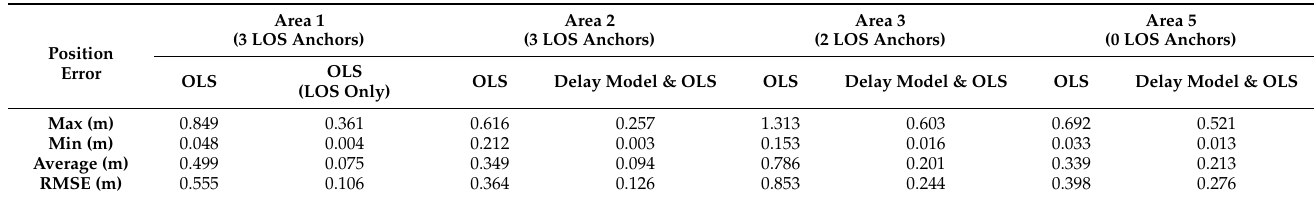
Table 4. Position accuracy analysis for delay